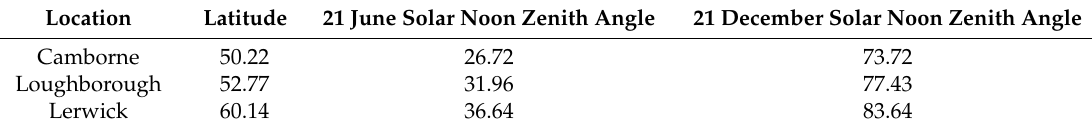
Table 3. Zenith angles for Camborne, Loughborough and Lerwick.